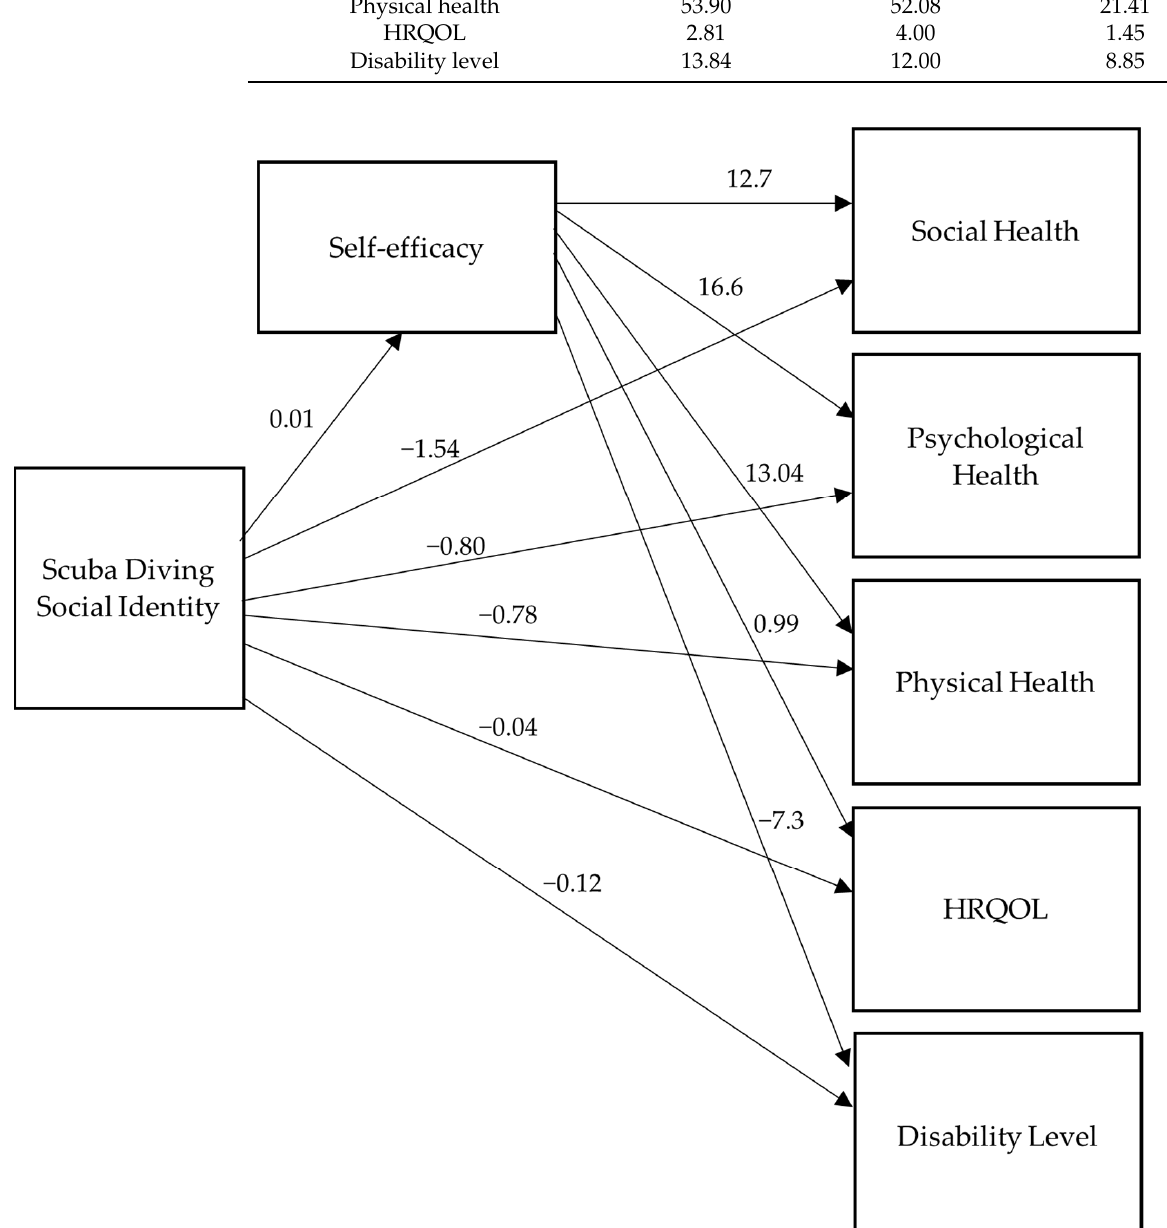
Figure 3. Unstandardized path model results.